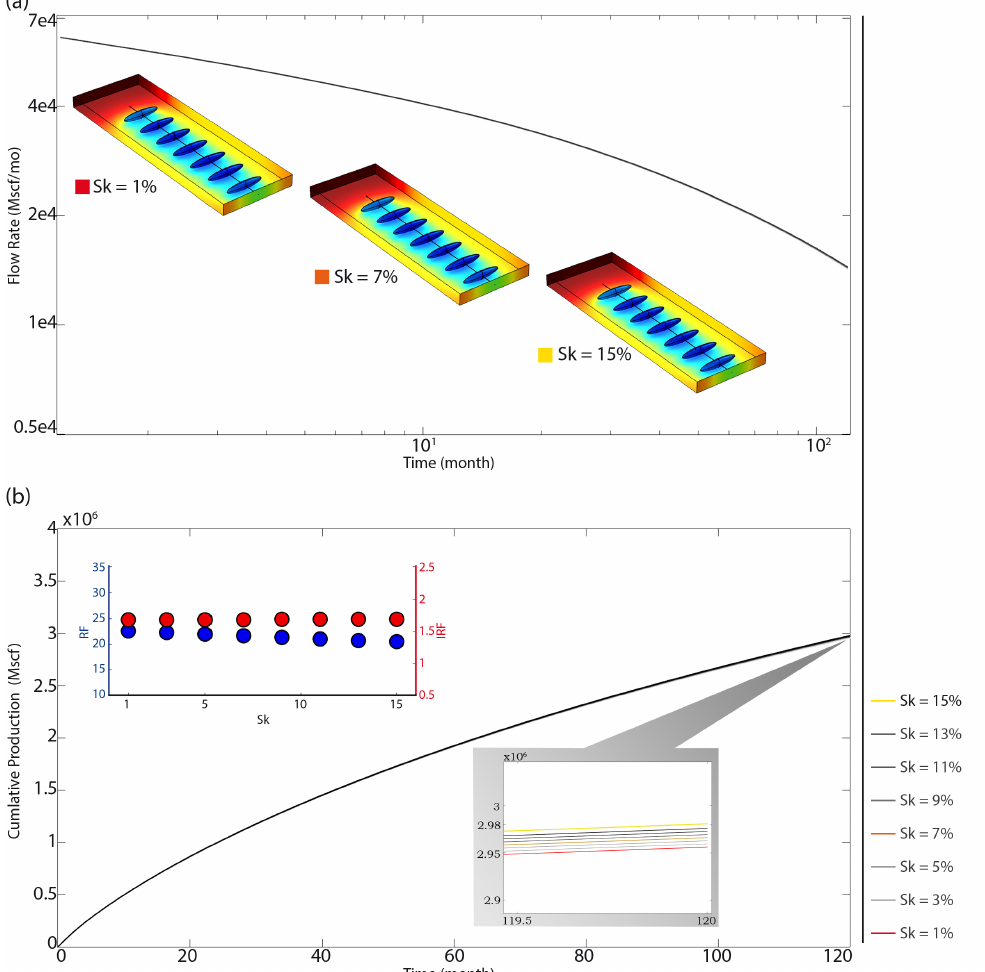
Figure 7. Impact of kerogen content. Flow rate production of methane in log-log scale. The snapshots represent the BCa field pressure at the end of the well life for different kerogen content ( a ). Cumulative production of methane in log-log scale ( b ). Ten year simulation. Field pressure colormap takes the value range that appears in the Figure